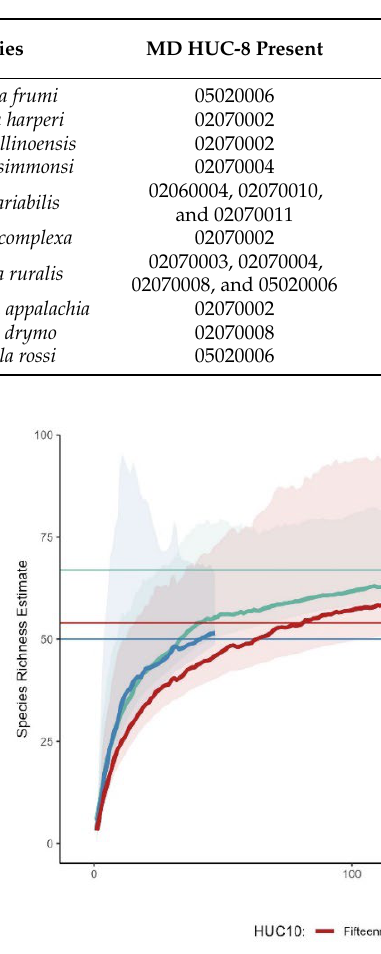
Table 14. Stonefly Species of Greatest Conservation Need (SGCNs) listed in USA states adjacent to Maryland with recorded presence within Maryland yet are not listed on the Maryland State Wildlife Action Plan (SWAP). USGS Hydrologic Unit Code (HUC)-8 basins with known Maryland presence are indicated. Number of Maryland records and elevation of collection localities are provided. State abbreviations are as follows: Delaware (DE), Pennsylvania (PA), Virginia (VA), and West Virginia (WV).